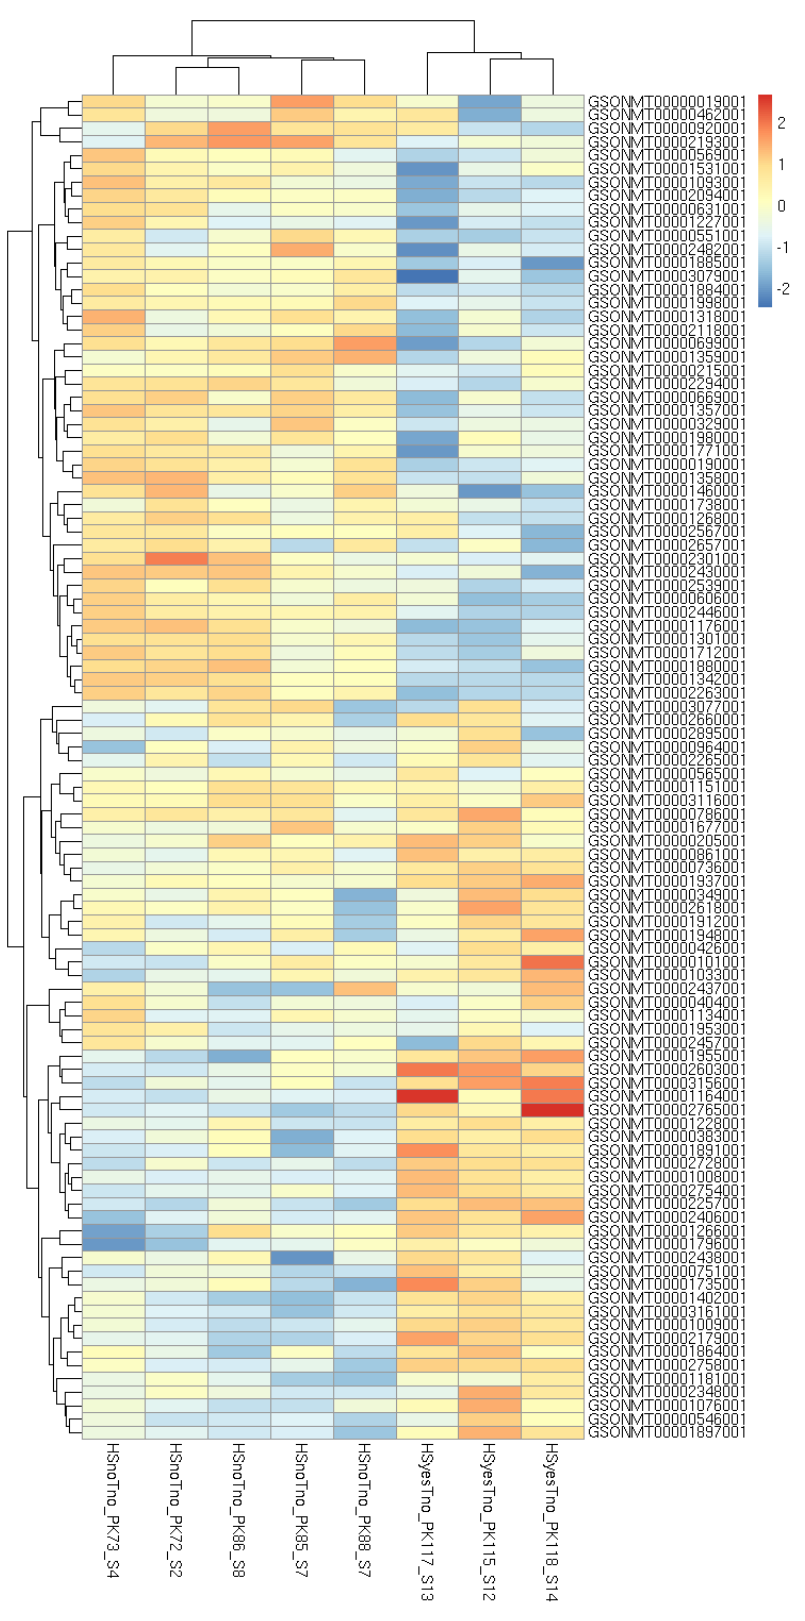
Figure 2. Heatmap of 100 most significant differentially expressed genes affected by increased temperature without a taxifolin treatment.